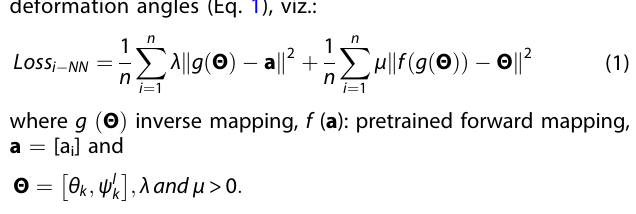
) and predicts a set of geometric features ( a (cid:4) ). The i-NN 1 (cid:1) 2 1 (cid:1) 4 , ψ (cid:4) 1 (cid:1) 2 ) and 1 (cid:1) 2 1 (cid:1) 2 vs desired ψ 1 (cid:1) 2 . The 1 (cid:1) 2 1 (cid:1) 2